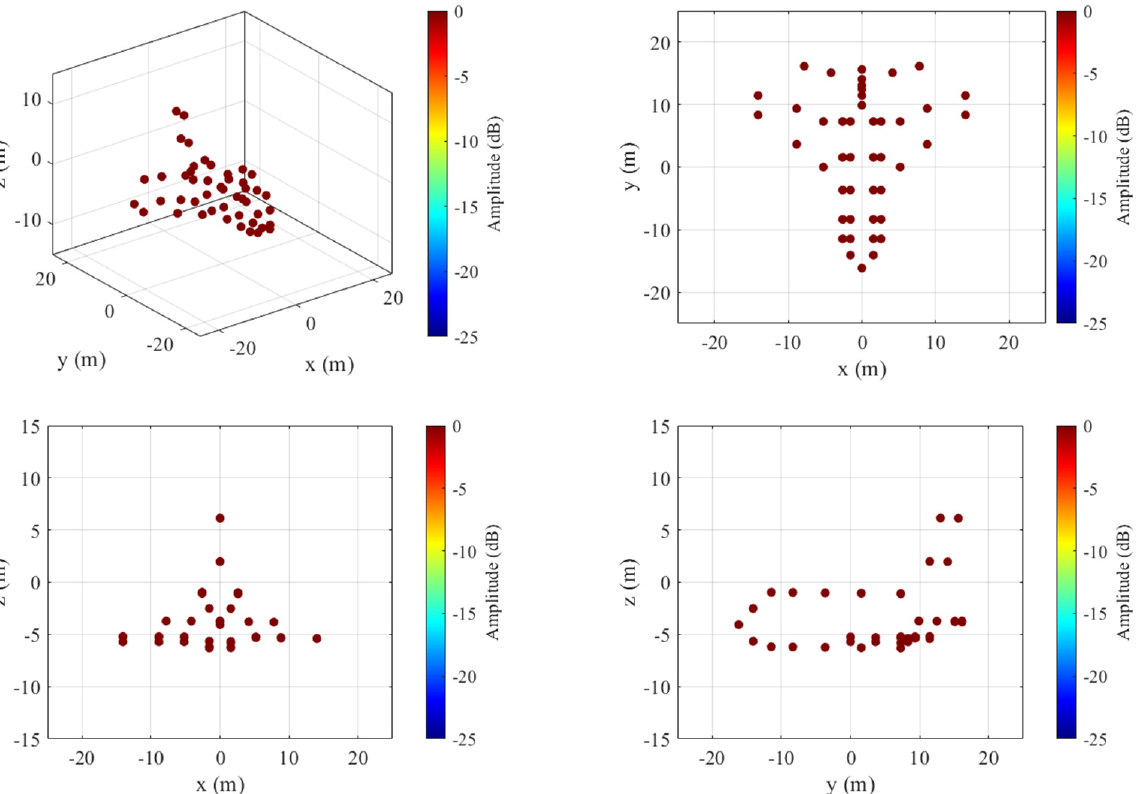
Figure 7. 3D positions of the scattering centers of the simulated target.